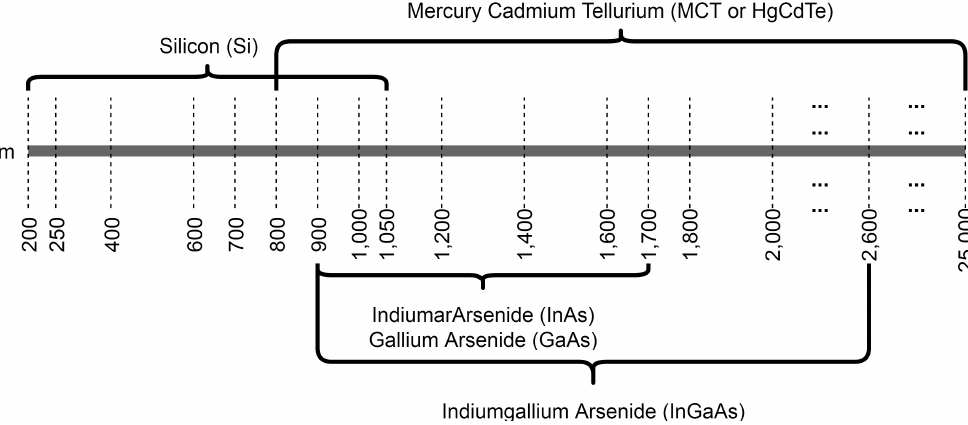
Figure 3. Materials involved in hyperspectral sensors fabrication (inspired by [43]): Silicon (Si) is used for acquiring ultraviolet, visible and shortwave NIR regions; indium arsenide (InAs) and gallium arsenide (GaAs) have a spectral response between 900–1700 nm; indium gallium arsenide (InGaAs) extends the previous range to 2600 nm; and mercury cadmium tellurium (MCT or HgCdTe) is characterized by a large spectral range and high quantum efficiency that enables reaching mid-infrared region (about 2500 to 25,000 nm) and NIR region (about 800–2500 nm).